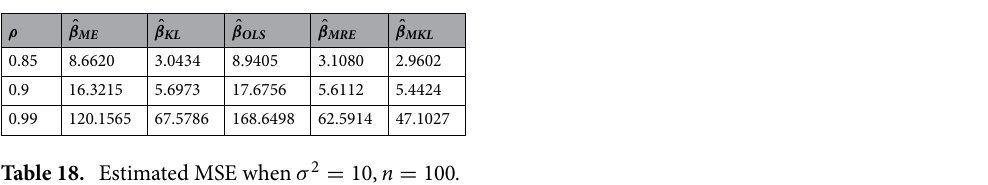
Table 17. Estimated MSE when σ